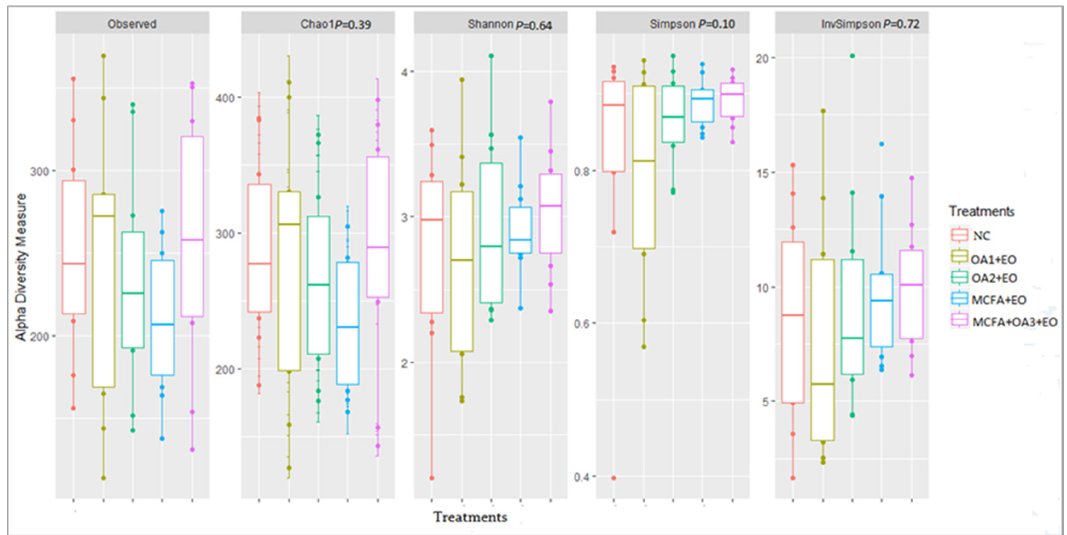
Figure 1. Alpha diversity indices of the ileal microbiota of broiler chickens at d 41 of age. (NC: Negative control; OA1: Malic acid + fumaric acid; OA2: Calcium butyrate + fumaric acid; OA3: Calcium butyrate + fumaric acid + citric acid + MCFA; MCFA: Capric-caprylic acid + caproic acid + lauric acid; AC: Cinnamaldehyde, carvacrol, and thymol as major